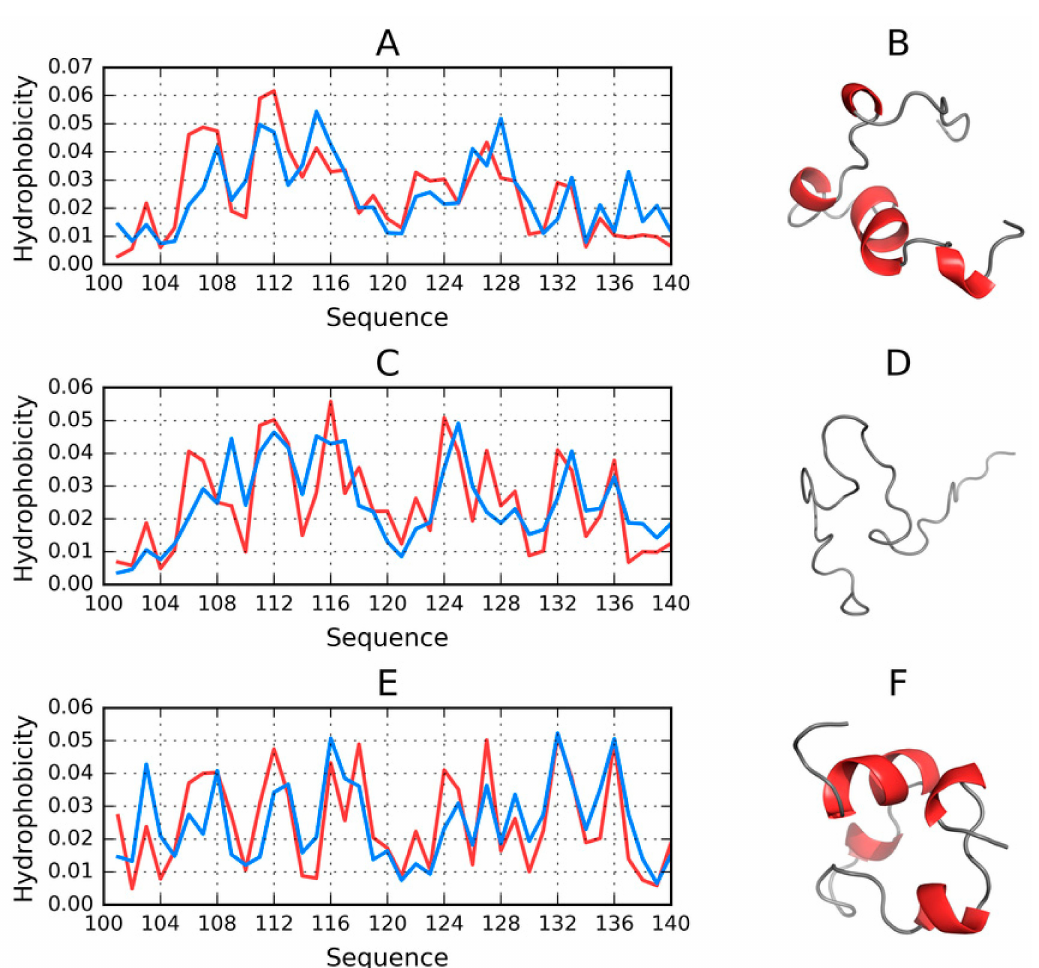
Figure 8. 3D visualizations, theoretical (T, blue) and observed (O, red) hydrophobicity density distribution profiles for models of 100–140 fragment, produced by each software package and characterized by the lowest RD. ( A , B )—FOD_1_(002); ( C , D )—ITASSER_1_(5); ( E , F